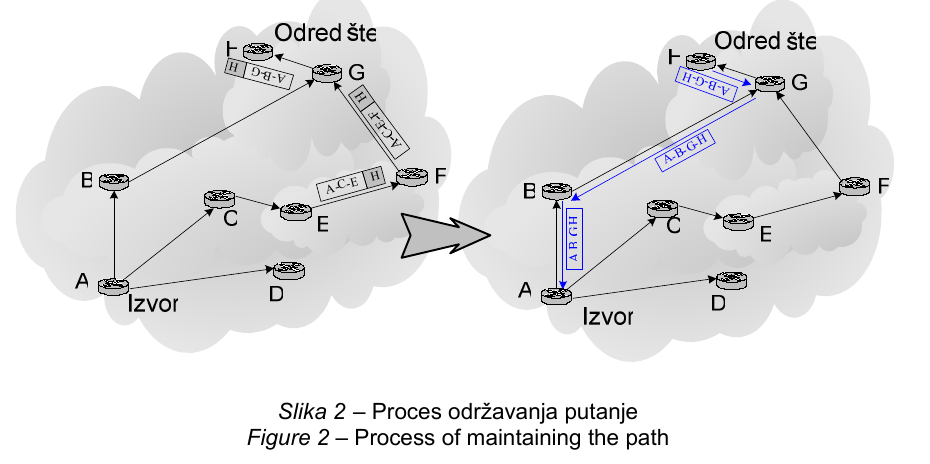
Figure 2 – Process of maintaining the